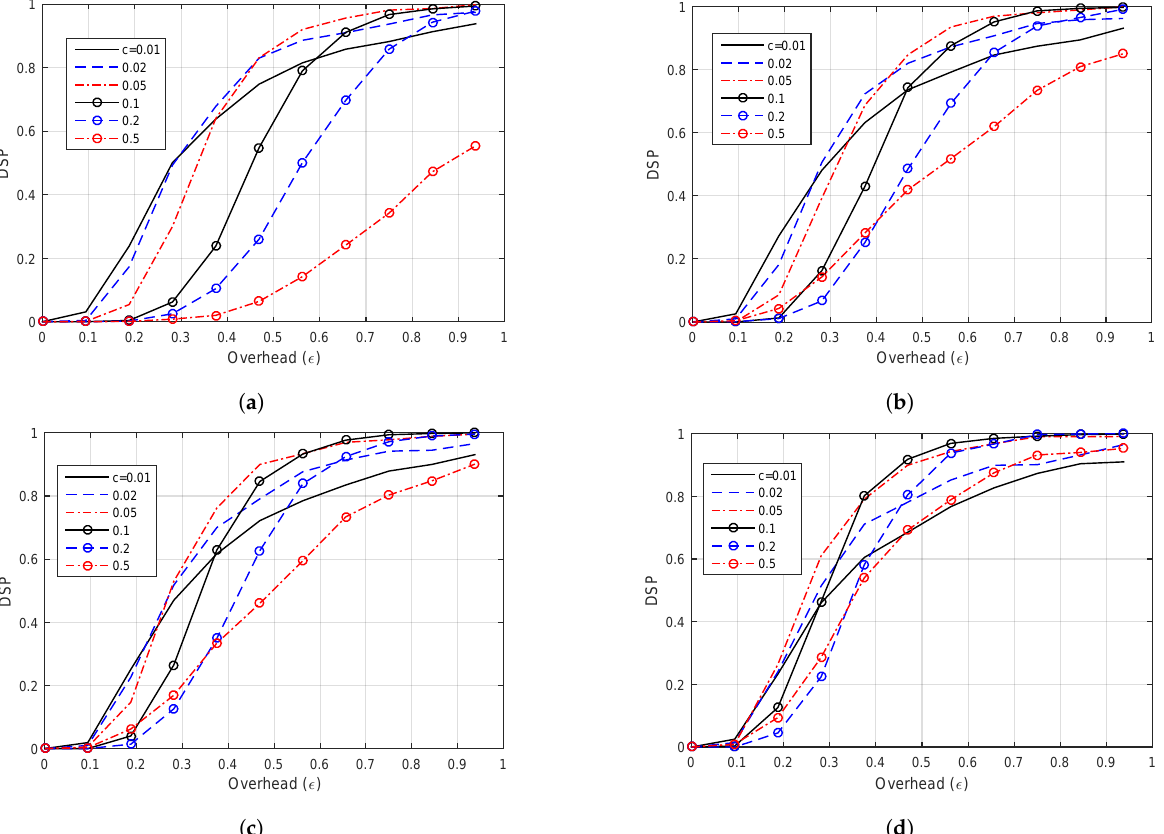
Figure 4. Decoding success probability (DSP) versus the overhead ( (cid:101) ) for LT codes of k = 128 at different values of c and δ . ( a ) δ = 0.05. ( b ) δ = 0.1. ( c ) δ = 0.2. ( d ) δ =